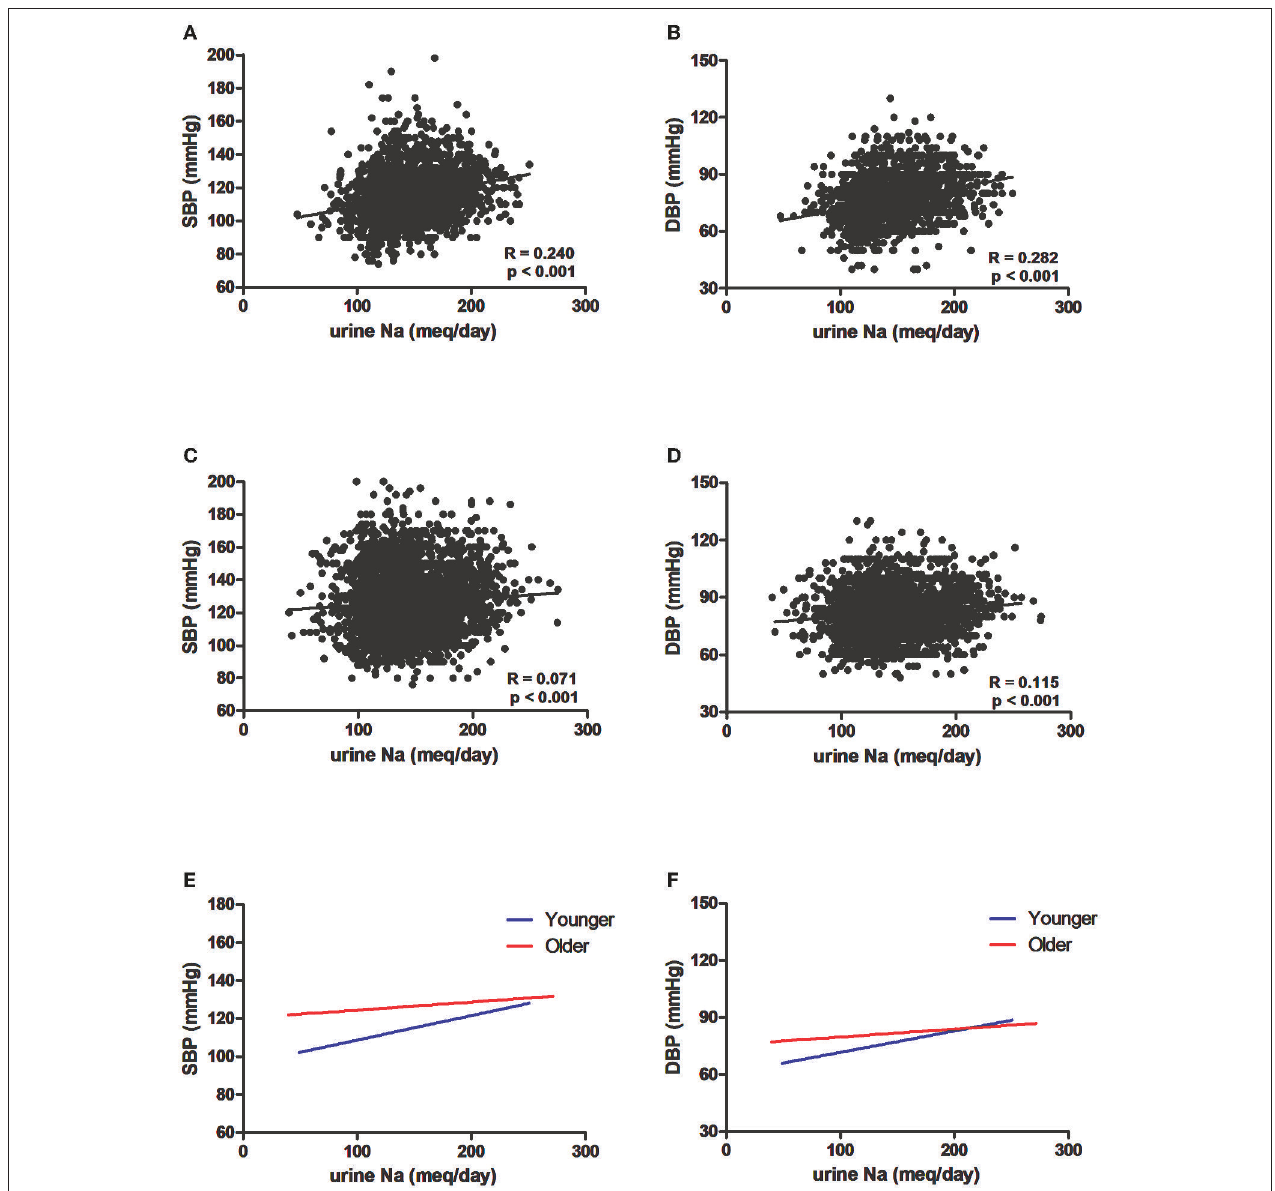
FIGURE 2 | Association between blood pressure and urine sodium in the Korean Genome and Epidemiology Study (KoGES). Association of (A) systolic blood pressure (SBP) and (B) diastolic blood pressure (DBP) with urine sodium in the younger group. Association of (C) SBP and (D) DBP with urine sodium in the older group (R: correlation coefficient, p : p -value). (E) Linear regression of SBP and urine sodium in both groups. (F) Linear regression of DBP and urine sodium in both groups (blue: younger group, red: older